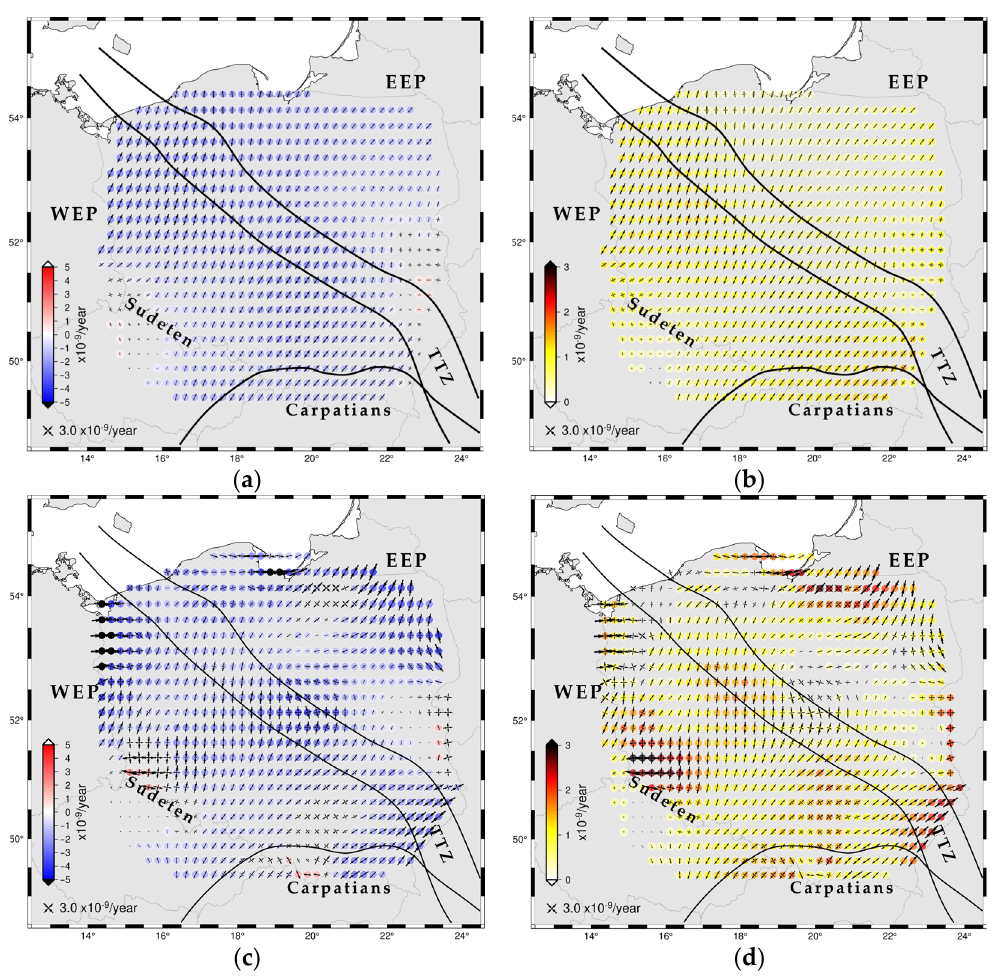
Figure 12. GPS strain rate maps, including dilatation strain ( left ) and shear strain ( right ), based on velocities validated by both ( a , b ) and at least one ( c , d ) method in 25 iterations. Simplified tectonic background based on [74,75]. EEP: East European Platform; WEP: West European Platform; TTZ: Teisseyre–Tornquist Zone.